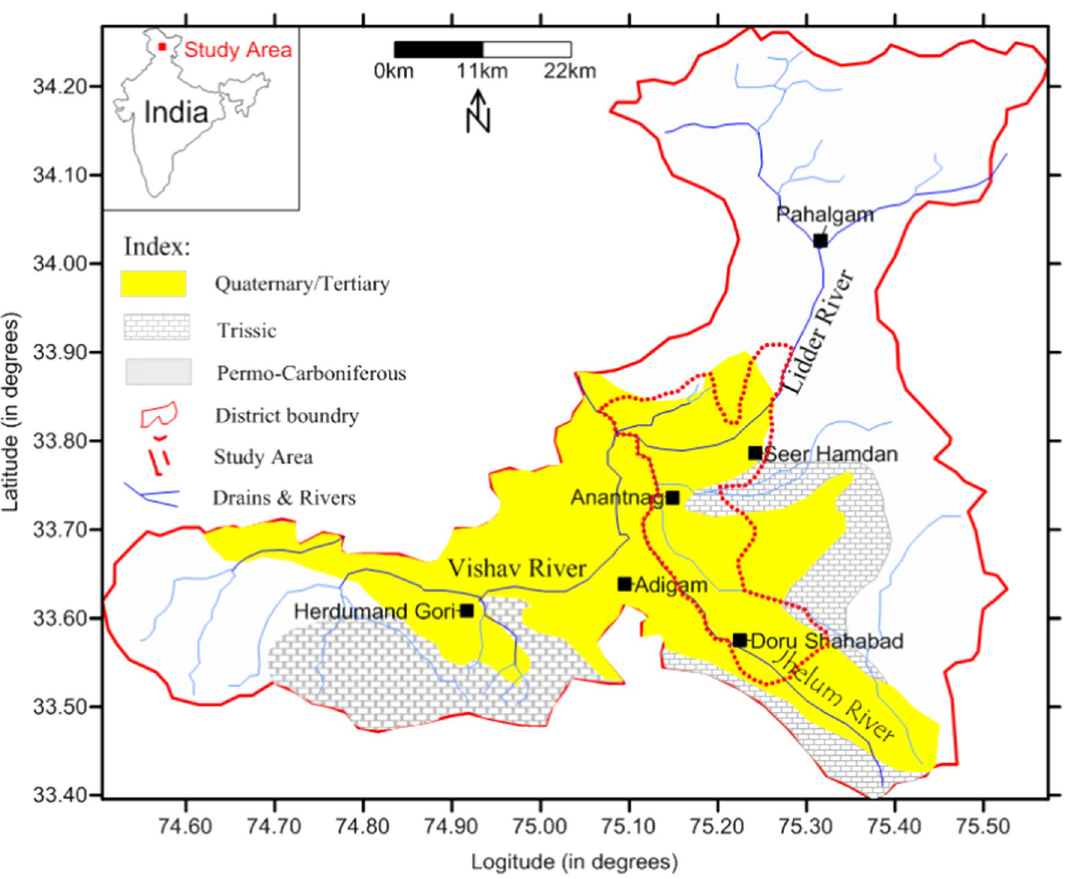
Fig. 1 Geological features and drainage network of the study area located in Anantnag district, Kashmir